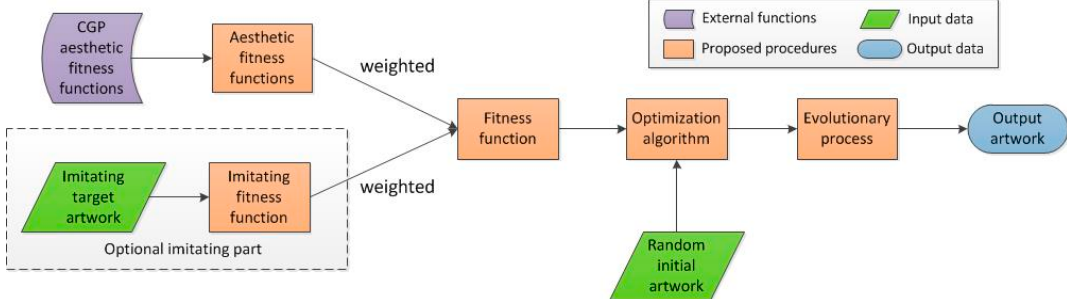
Figure 2. The flowchart of the proposed method.